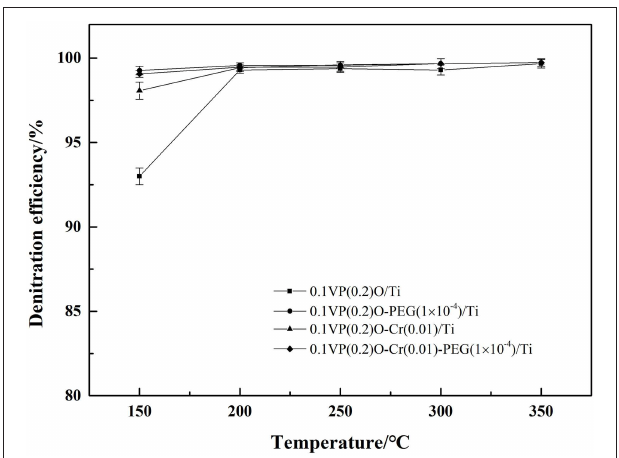
FIGURE 4 | Outlet concentration of NO x and SO 2 vs. time over 0.1VP(0.2)O-Cr(0.01)-PEG(1 × 10 − 4 )/Ti catalyst.